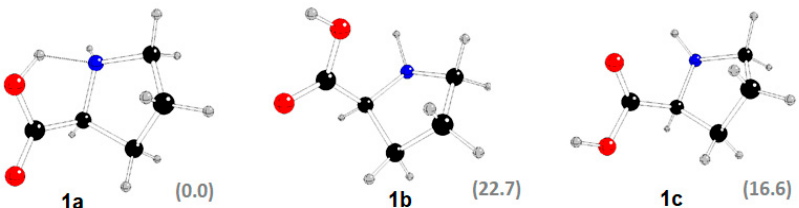
Figure 3. Optimized geometry of L -proline, structure 1a, b and c with corresponding relative Gibbs free energies at 298 K (in kJ/mol) in parentheses ( C —black, N —blue, O – red, H —grey).